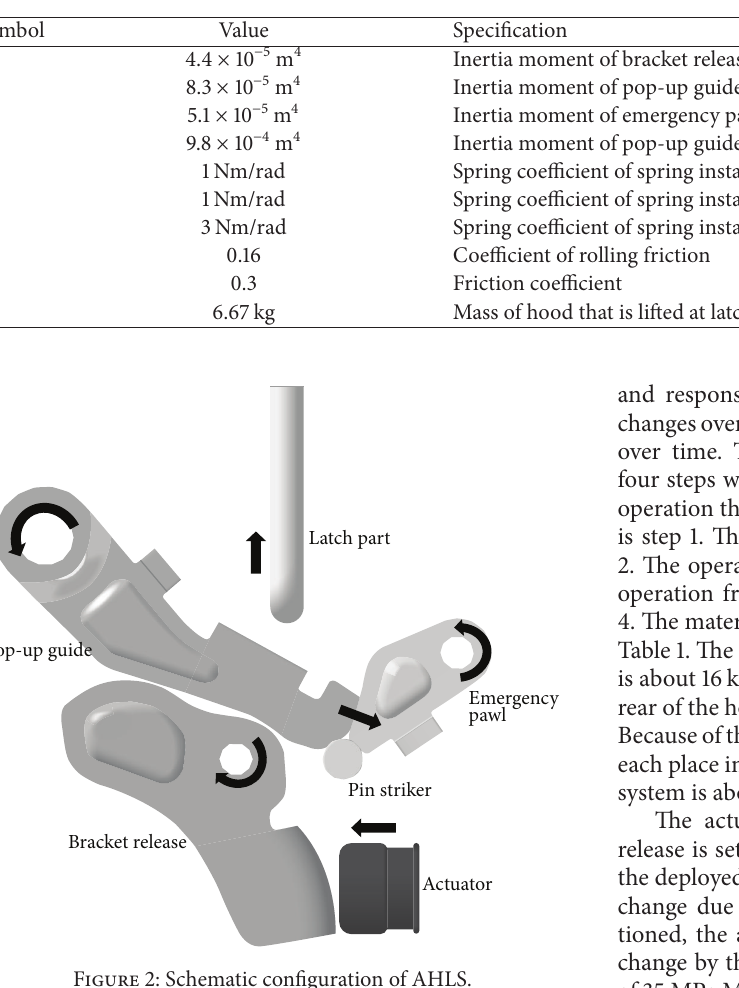
Table 1: Material properties of AHLS.